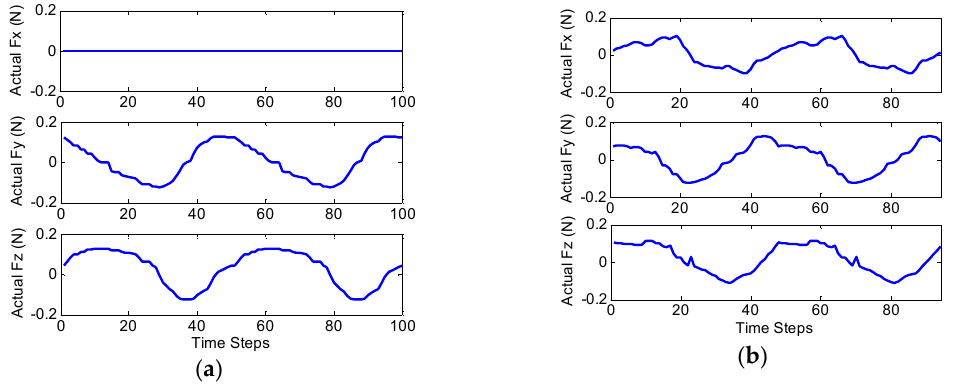
39.99 m , k   and Figure 9. True values of external forces applied to the catheter tip: ( a ) 1 1,0 Figure 9. True values of external forces applied to the catheter tip: ( a ) Figure 9. True values of external forces applied to the catheter tip: ( a ) k 1,0 “ 39.99 m ´ 1 , and 24.57 m , k   and quasi-sinusoidal spatial force quasi-sinusoidal planar force exertion; ( b ) 1 1,0 quasi-sinusoidal planar force exertion; ( b ) k 1,0 “ 24.57 m ´ 1 , and quasi-sinusoidal spatial force application. application.